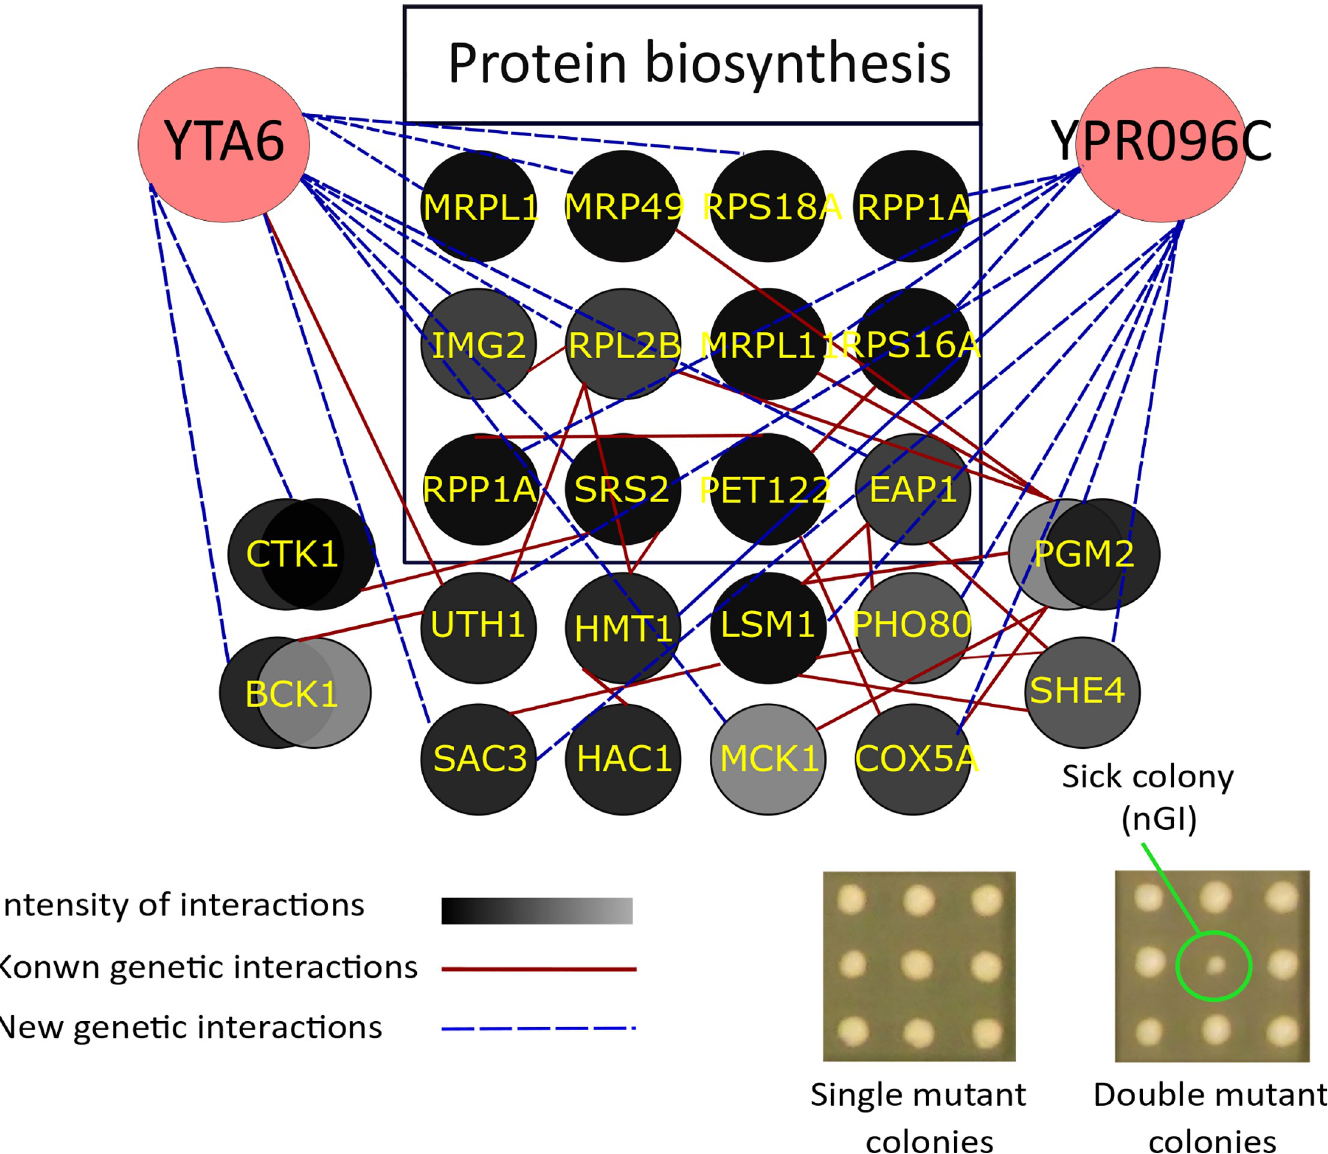
Fig 6. Conditional nGIs for YTA6 and YPR096C in the presences of 3 mM concentration of LiCl. Our data shows a cluster of interactors involved in the protein biosynthesis pathway for YTA6 (P = 1.6e-4) and YPR096C (P = 6.6e-4). CTK1 , HAC1 , BCK1 , MRPL1 , and PGM2 are mutual hits shared between YTA6 and YPR096C . Circles represent genes, dashed lines represent nGIs identified in this study and solid lines represent previously reported interactions in the literature. The inset represents an example of a typical interaction.